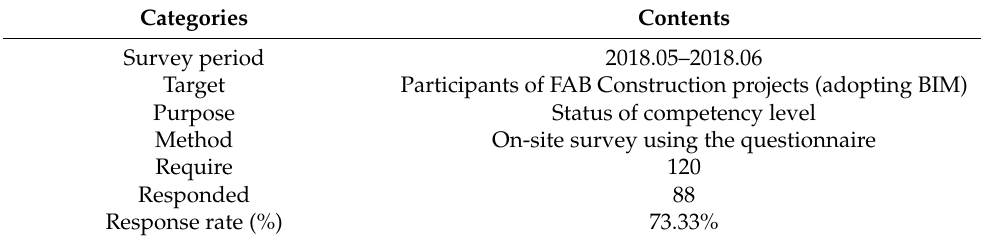
Table 3. Overview of the survey conducted.